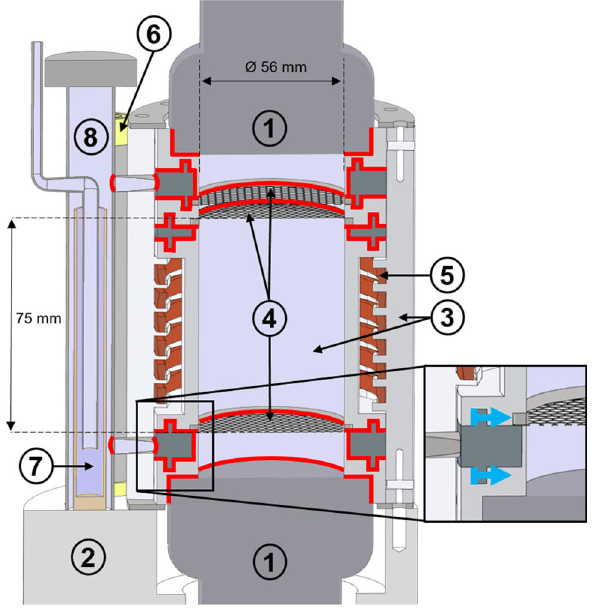
Fig. 1 CAD drawing of the hermetic TPC. The inner volume is indi- cated by the light blue color: (1) PMTs, (2) aluminum filler, (3) PTFE reflector/structural components, (4) cathode, gate, anode electrodes, (5) field shaping electrodes, (6, partially hidden) levelmeter recording the LXe level of the outer volume, (7) weir to set the LXe level in the inner volume, installed inside a (8) stainless steel vessel. A similar vessel contains a levelmeter measuring the LXe level of the inner volume. The inset illustrates how the TPC is sealed at the interface of the PTFE chamber (white) and the cathode electrode support frame (dark gray) by means of cryofitting: when being cooled down, the shrinking PTFE exerts a force (blue arrow) onto the steel of the electrode support ring. All sealing surfaces of the TPC are marked in red